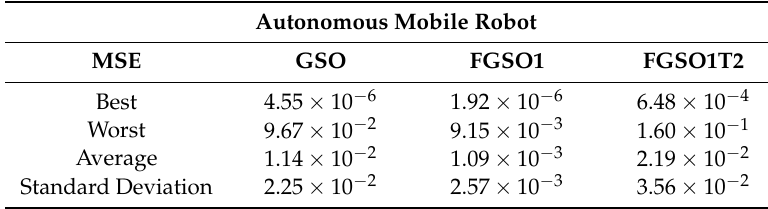
Table 2. Results without noise for GSO.